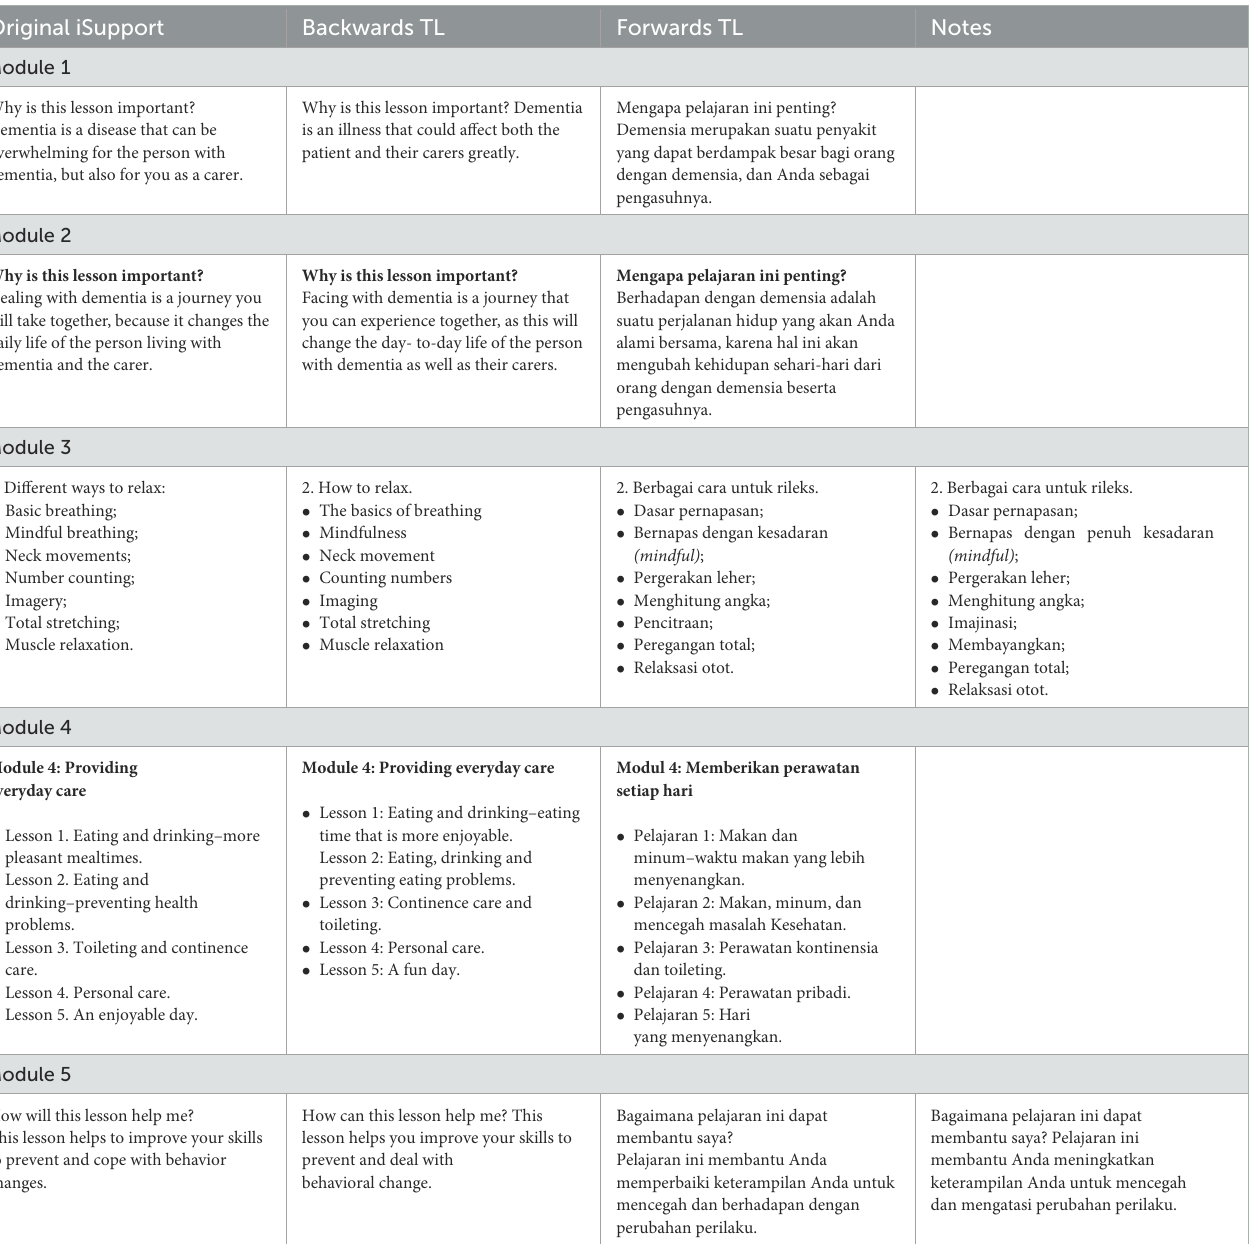
TABLE 2 Translation backward and forward, and technical accuracy. Original